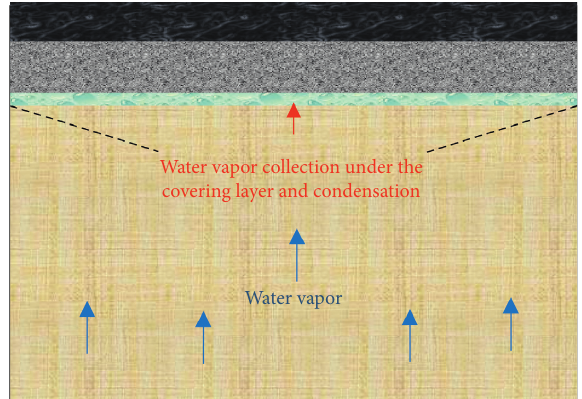
Figure 1: Schematic of water vapor migration in the subgrade with a covering